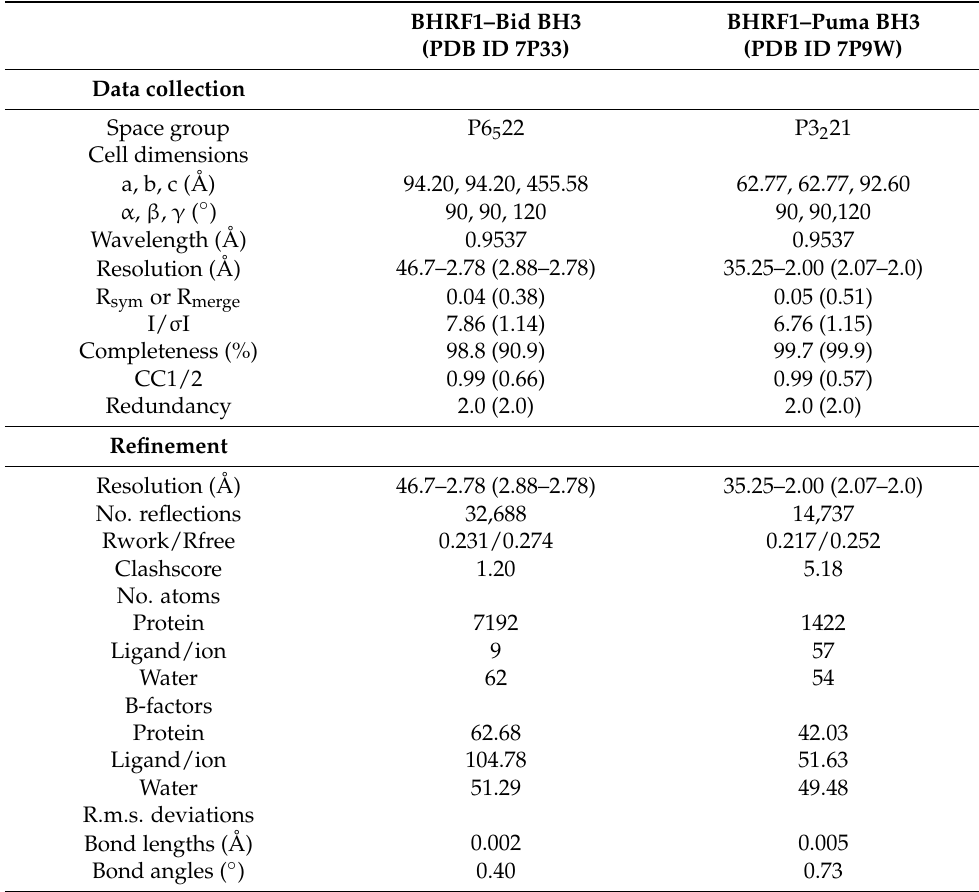
Table 1. X-ray crystallographic data collection and refinement statistics. Values in parentheses are for the highest resolution shell.